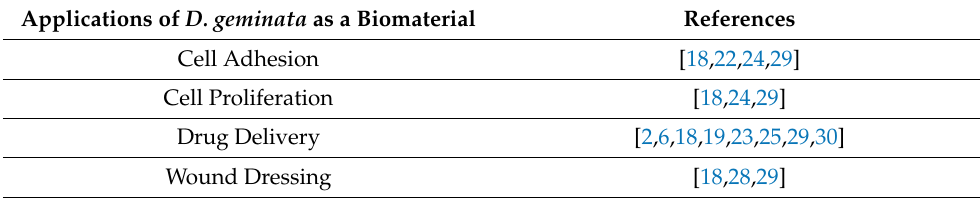
Table 1. References corresponding to the different applications of D. geminata as a biomaterial. Applications of D. geminata as a